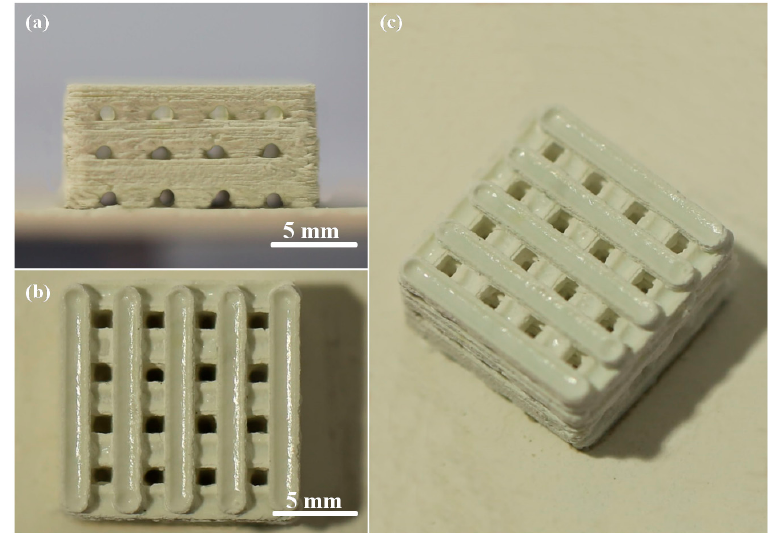
Figure 1. ( a ) Front view; ( b ) top view and ( c ) oblique view of the CaSO 4 /bioglass scaffold with zinc oxide whisker (ZnOw).